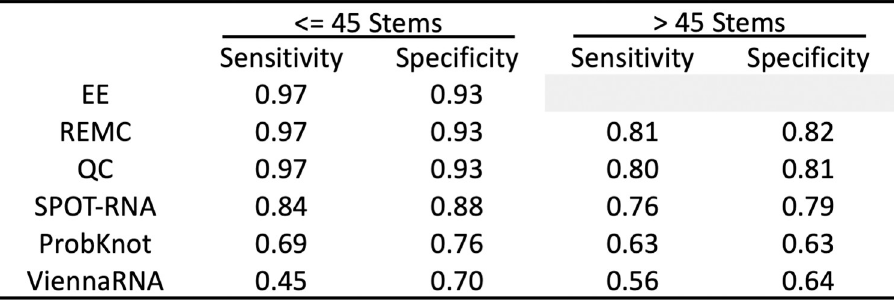
Fig 4. Comparison of methods on the datasets described in previous sections. Exact Enumeration (EE) is not computed for systems containing more than 45